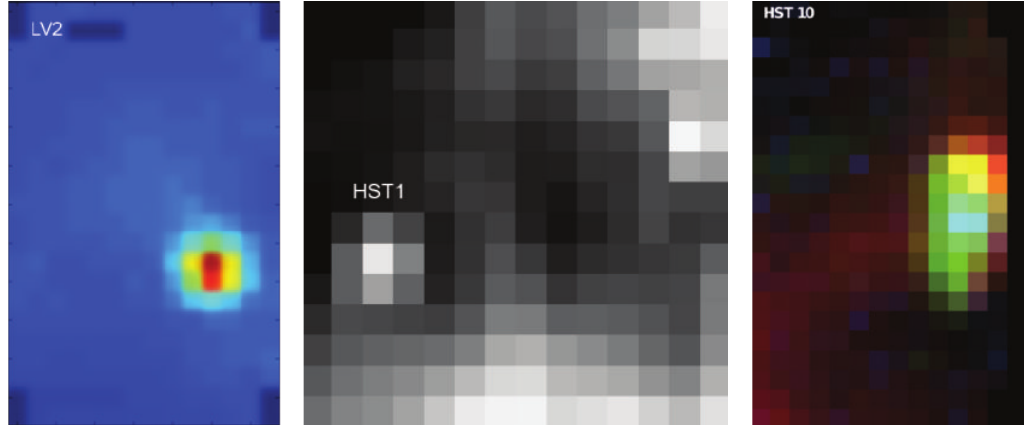
Figure 6: Spatial distributions maps of LV2 in H 𝛽 [66], HST1 in H 𝛼 [65] and HST10 as a combination of H 𝛼 (red), [O I] 6300 ˚A (green), and [O I] 5577 ˚A (blue) [67]. A comparison with Figure 1 is